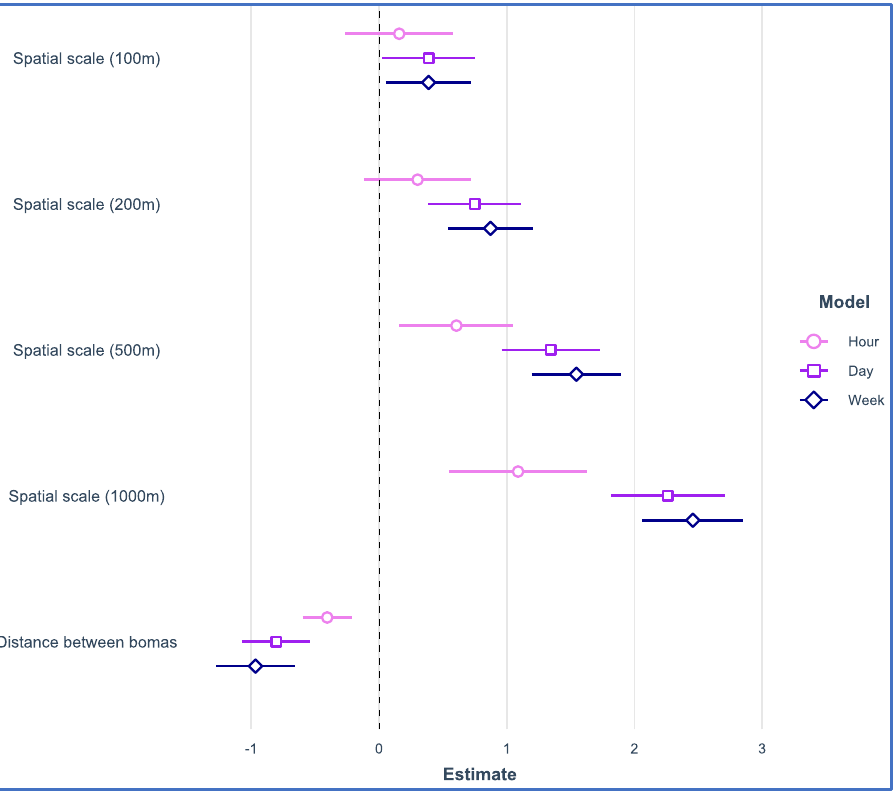
Figure 4. The relative effect size of temporal and spatial definitions of contact, and distances between bomas, on the pairwise contact rate (hr −1 ). Symbols denote estimated coefficients (± 95% CI) from three separate models. The effect size of spatial scale coefficients are relative to the reference level of 50 m in all